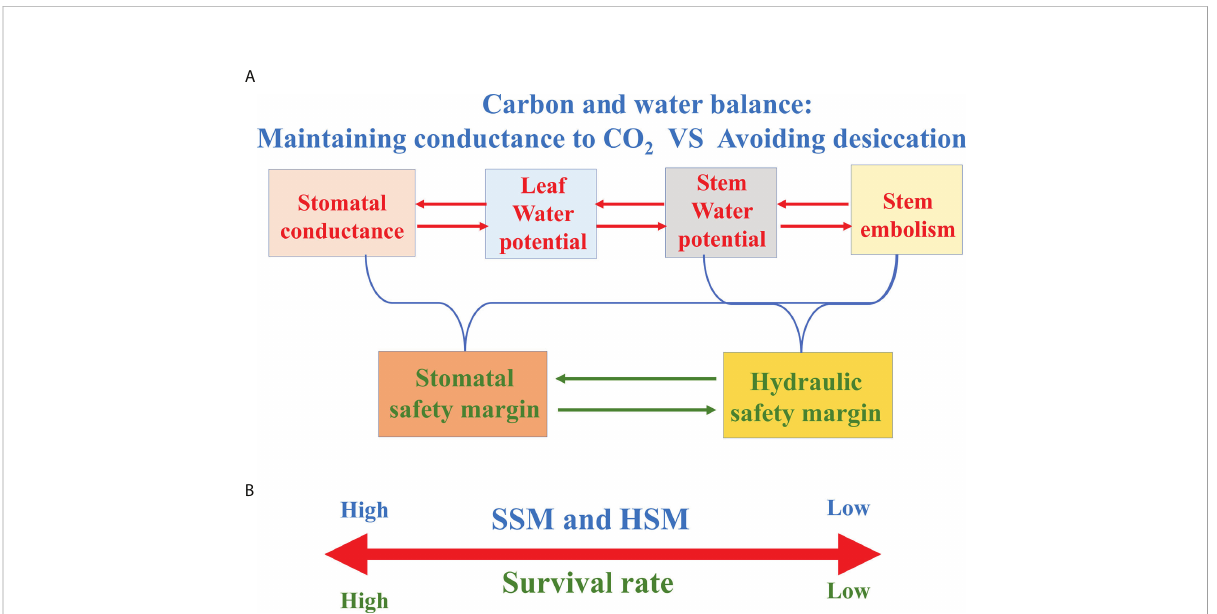
FIGURE 5 (A) Frame diagram characterizing the relationships between stomatal conductance, leaf/stem water potential and stem xylem embolism. (B) The survival rate of tree species with greater hydraulic safety margin (HSM) or stomatal safety margin (SSM) is higher under drought